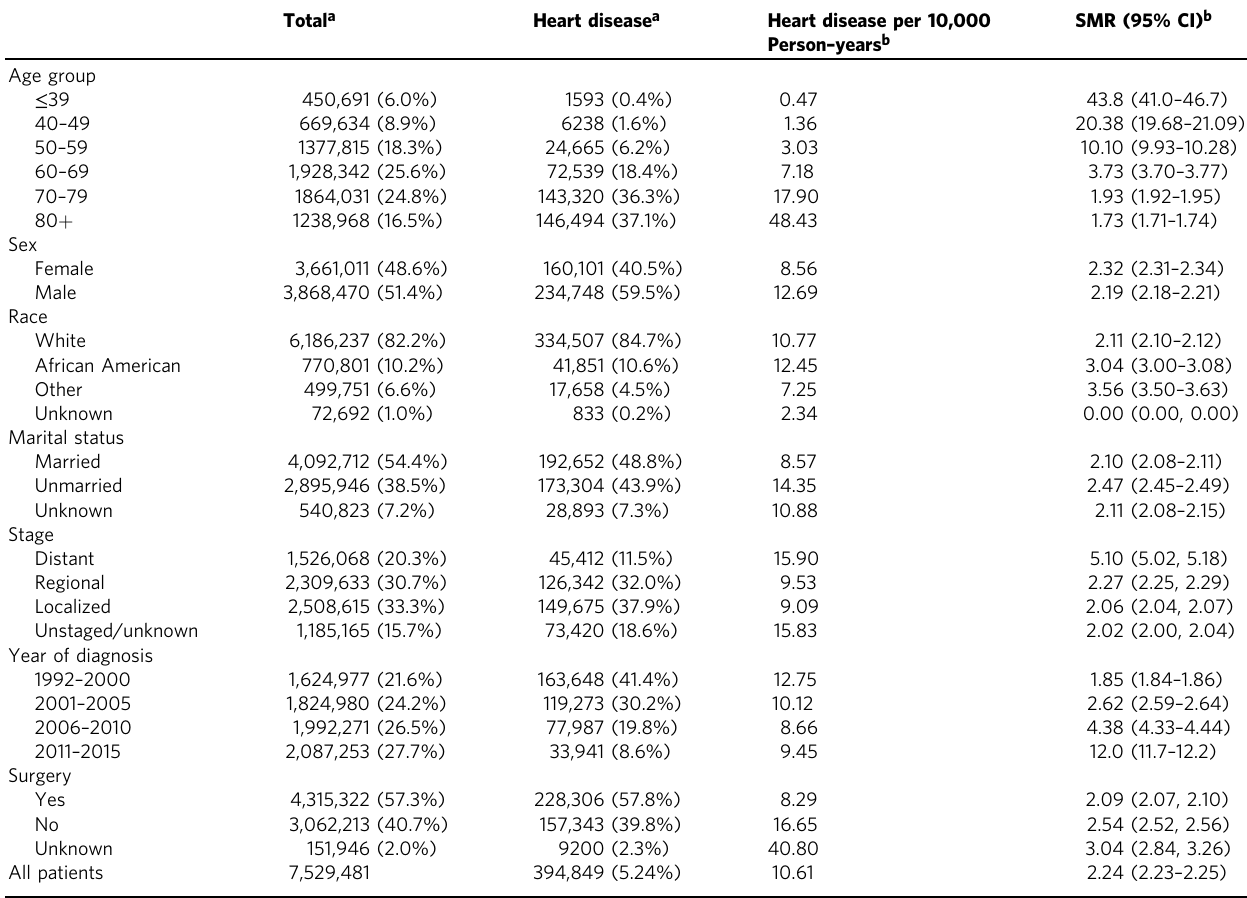
Table 1 Standardized mortality ratios of heart disease death among cancer patients. Total a Heart disease